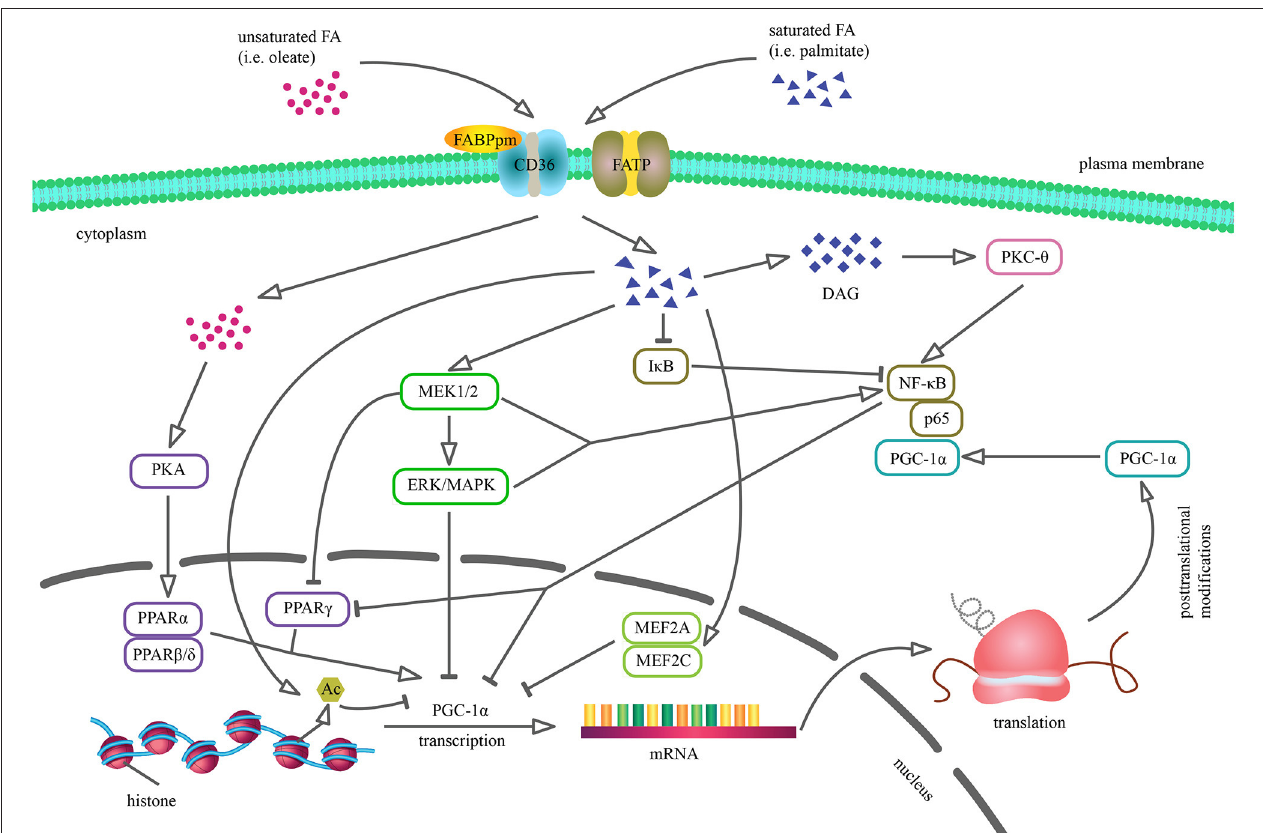
FIGURE 1 | Cellular mechanisms by which saturated and unsaturated fatty acids may alter PGC-1 α expression and activity. Palmitic acid incorporation reduces PGC-1 α transcription through the activation of ERK/MAPK cascade, reduction of MEF2 transcription factor DNA binding and stimulation of I κ B proteasomal degradation. Moreover, saturated FA contribute to MEK1/2-dependent NF- κ B stimulation and DAG accumulation that results in PKC θ -mediated NF- κ B induction. PGC-1 α downregulation via NF- κ B may involve several processes, including direct repression as p65 subunit of NF- κ B is constitutively physically bound to PGC-1 α as well as reduced PPAR γ activity, because PGC-1 α promoter sequence contains PPRE. Palmitate-induced histone deacetylation results in reduced PGC-1 α promoter activity and inhibits PGC-1 α expression. Conversely, oleate enhances PGC-1 α mRNA level via PKA-PPAR α pathway, thus reversing the coactivator’s previous level (Coll et al., 2006, 2008; Crunkhorn et al., 2007; Alvarez-Guardia et al.,